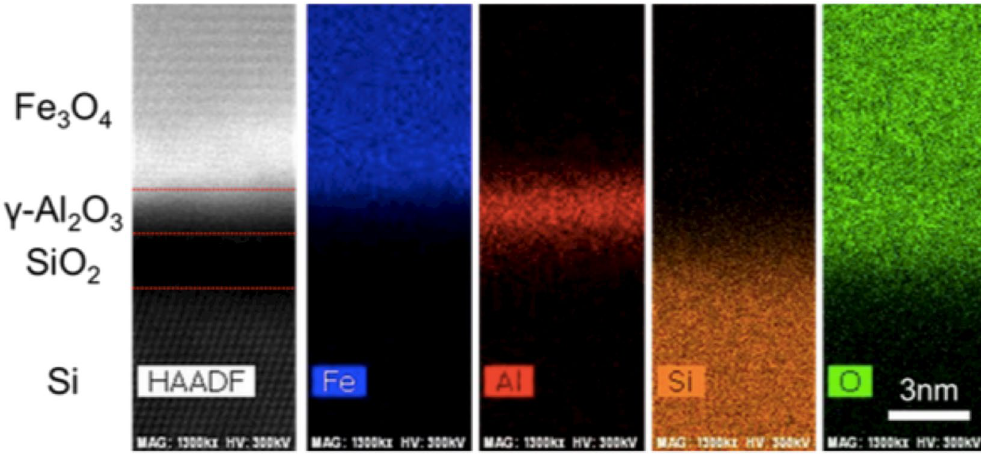
Figure 5. The EDS mapping of the heterostructure: From the left image, HAADF image, EDS mapping of Fe, Al, Si, and O.